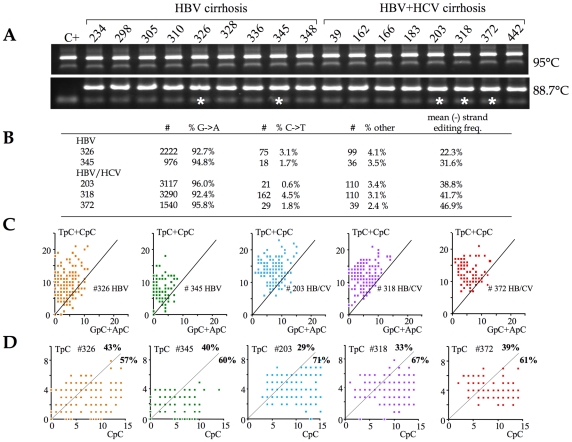
A3 deaminases are the major editors of HBV DNA in vivo.A) PCR and 3DPCR amplification at the normal and restrictive temperatures of 95°C and 88.7°C respectively. Sample codes are given above. Five 3DPCR samples identified by asterisks were chosen for cloning and sequencing. B) Summary of the unique hyperedited sequences in the form of the number and fraction of G→A (minus stand) edits, C→T (plus strand) and all other point mutations. The excess of GC→AT transitions over all other mutations varied from 23–40 fold. C) Clonal analysis using the number of TpC+CpC vs. GpC+ApC targets edited. The vast majority of patient sequences map to the area typical of APOBEC deaminases. D) Clonal analysis using the number of TpC vs. CpC targets edited. The majority of sequences map to the area typical of APOBEC3G (between 57–71% marked in bold face).